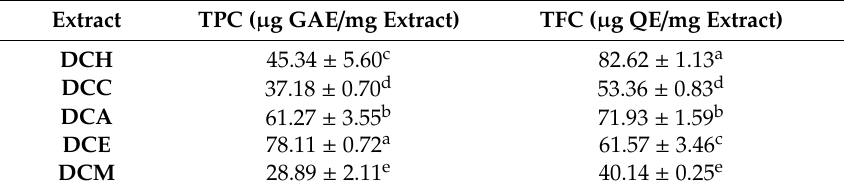
Table 1. Total phenolic and flavonoid contents in the extracts.